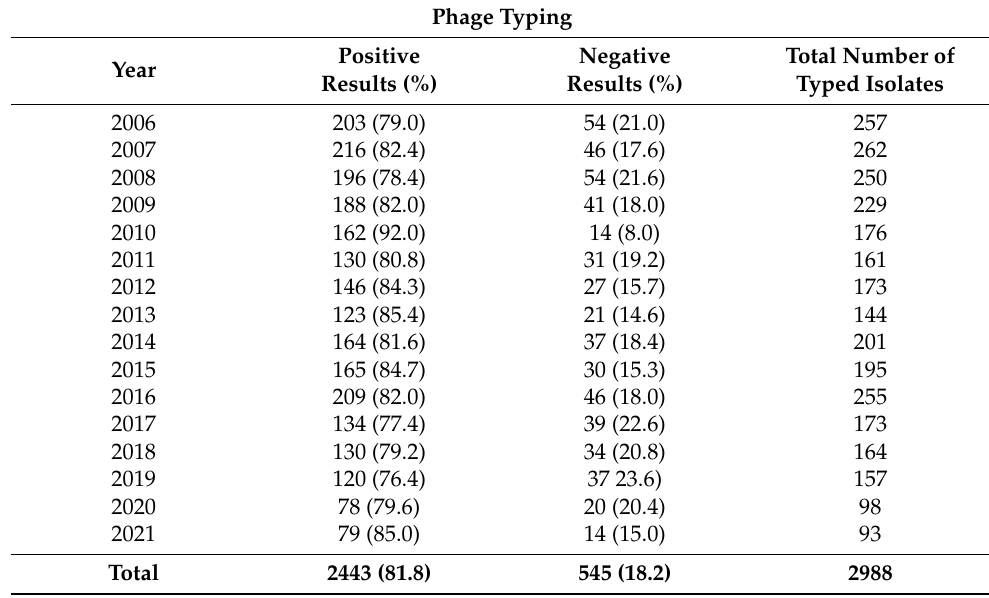
Table 3. Results of phage typing performed for PTU patients in the years 2006–2021 (source: internal